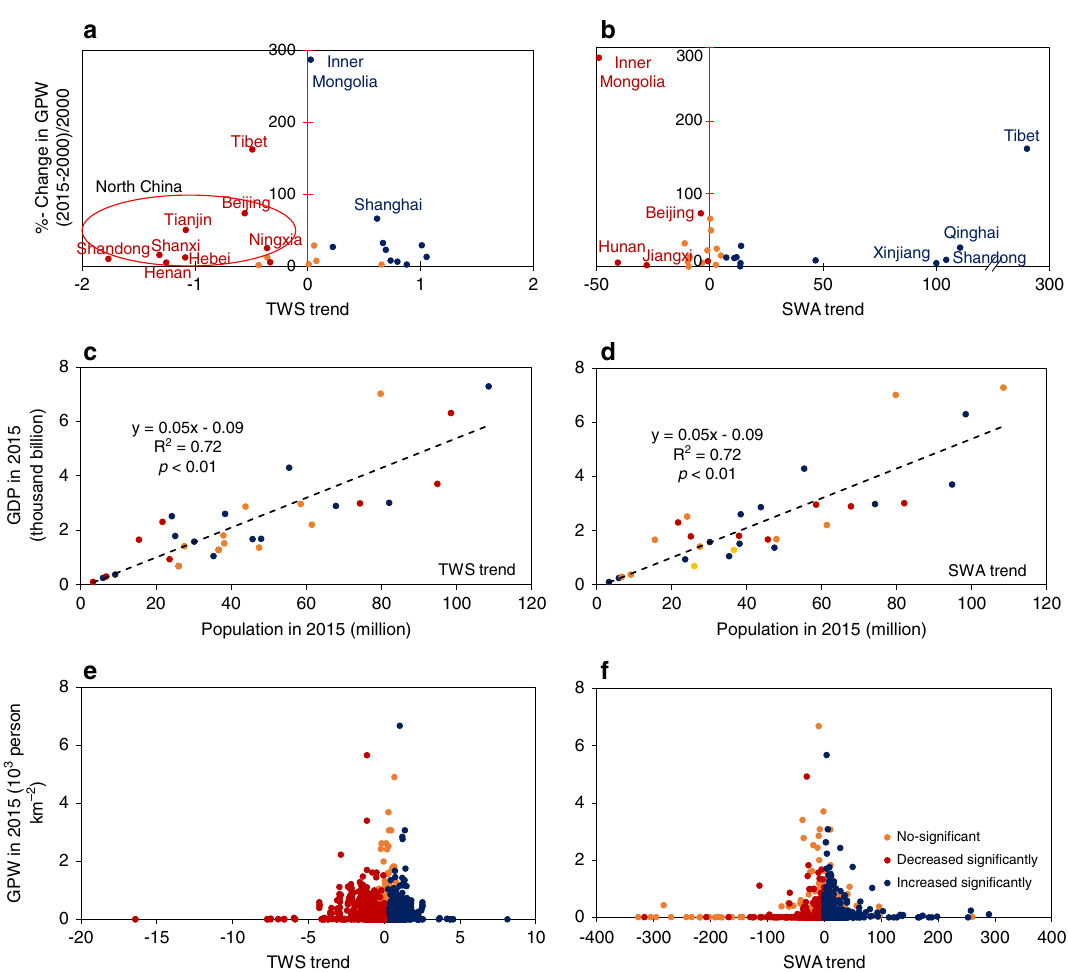
Fig. 5 Relationships between surface water area trends, GRACE terrestrial water storage trends, gross domestic product, and the Gridded Population of the World. a Relationship between population density changed from 2000 to 2015 and terrestrial water storage (TWS) trends at the provincial scale. b Relationship between population density changed from 2000 to 2015 and surface water area (SWA) trends at the provincial scale. c Relationship between population, gross domestic product (GDP) in 2015, and TWS trends at the provincial scale. d Relationship between population, GDP in 2015, and SWA trends at the provincial scale. e Relationship between TWS trends and Gridded Population of the World (GPW) in 2015 at the 0.5° gridcell scale. f Relationship between SWA trends and GPW in 2015 at the 0.5° gridcell